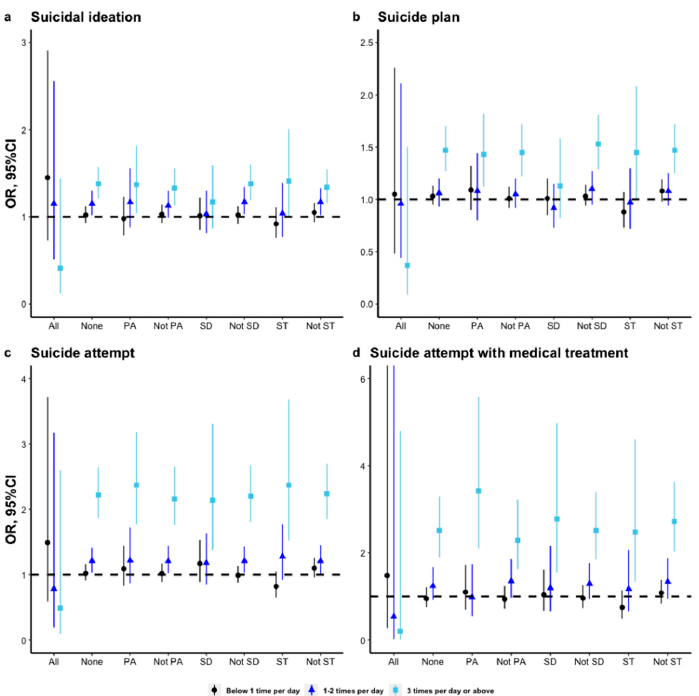
Figure 2. The association between soft drink consumption and suicidality by different recommendations of the 24 h movement guidelines among adolescents in the U.S. (OR: odds ratios, CI: confidence interval; All: meeting all the recommendations of the 24 h movement guidelines; None: meeting none of the recommendations of the 24 h movement guidelines; PA: meeting the recommendations of physical activity; Not PA: not meeting the recommendations of physical activity; SD: meeting the